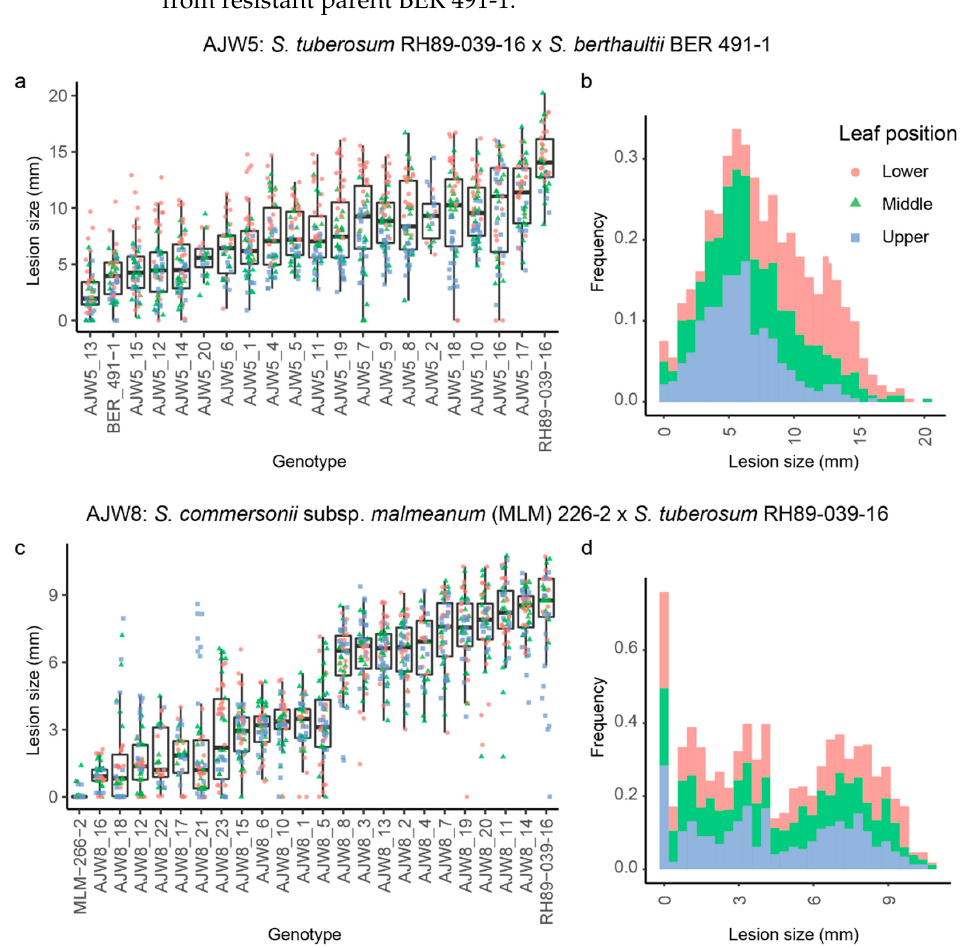
Figure 4. Quantitative and qualitative inheritance of early blight resistance in progeny of wild Solanum . Inheritance of early blight resistance was assessed by inoculating parents and progeny from the AJW5 population ( S. tuberosum RH89- 039-16 × S. berthaultii BER 491-1) and the AJW8 population ( S. commersonii subsp. malmeanum 226-2 × RH89-039-16.) Lesions measured on lower (red), middle (green) and upper (blue) leaves are visualised using boxplots ( a , c ) and the distribution of lesion sizes is shown in histograms ( b , d ).